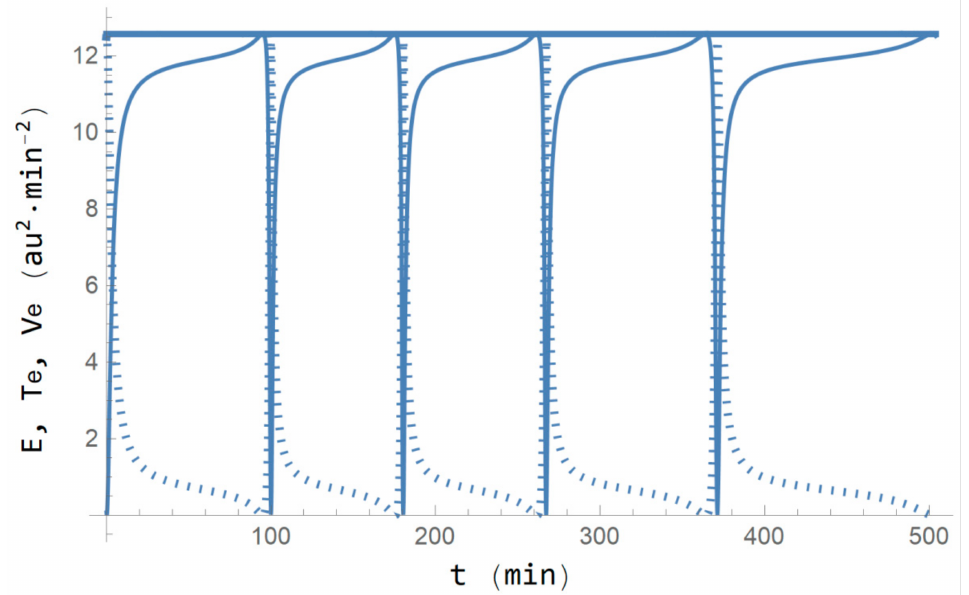
Figure 4. Ermakov–Lewis energy (E, upper straight line), kinetic energy ( T e , first increasing line), and potential energy ( V e , first decreasing dotted line), versus